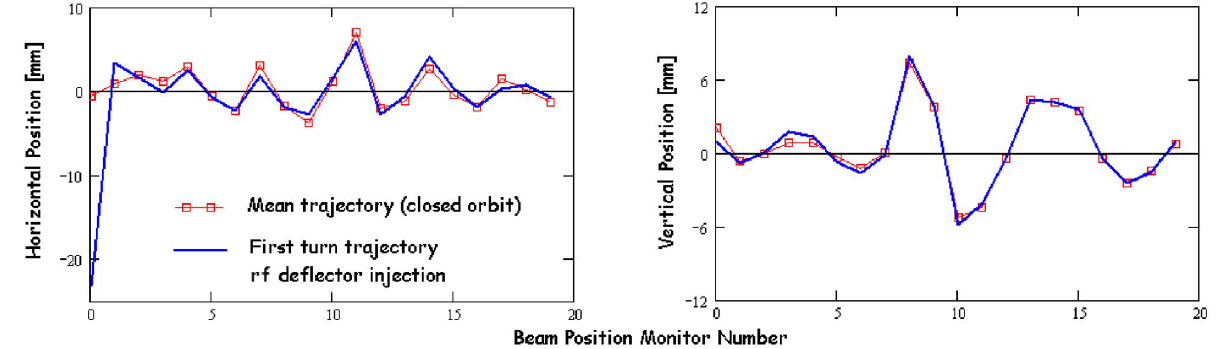
FIG. 18. (Color) Reference closed orbit and first turn trajectory in the isochronous ring in both planes. The reading in the first BPM shows the beam position at injection, before the deflector